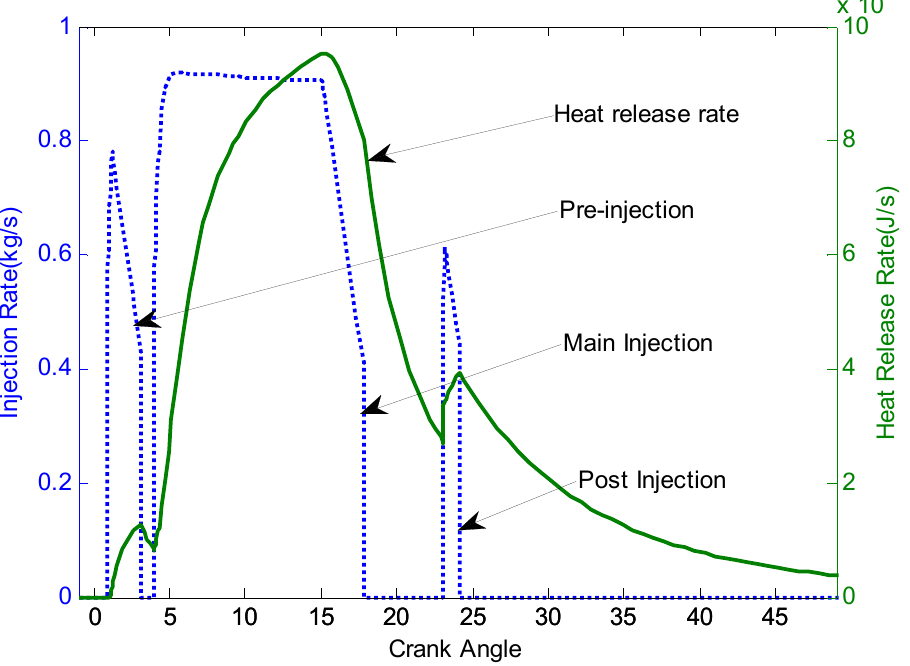
Figure 9. Heat release rate when a post injection occurs.